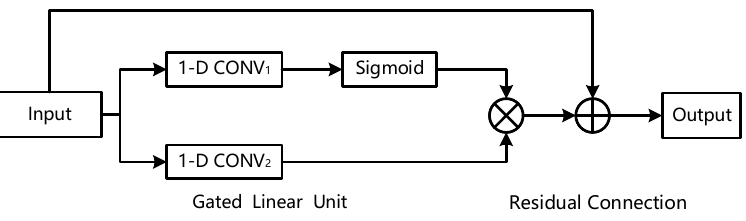
Figure 3. Basic unit of dilated gated convolutional neural network.